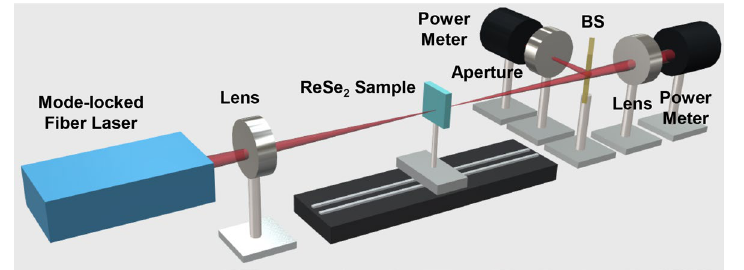
Figure 5. Measured setup for the Z-scan